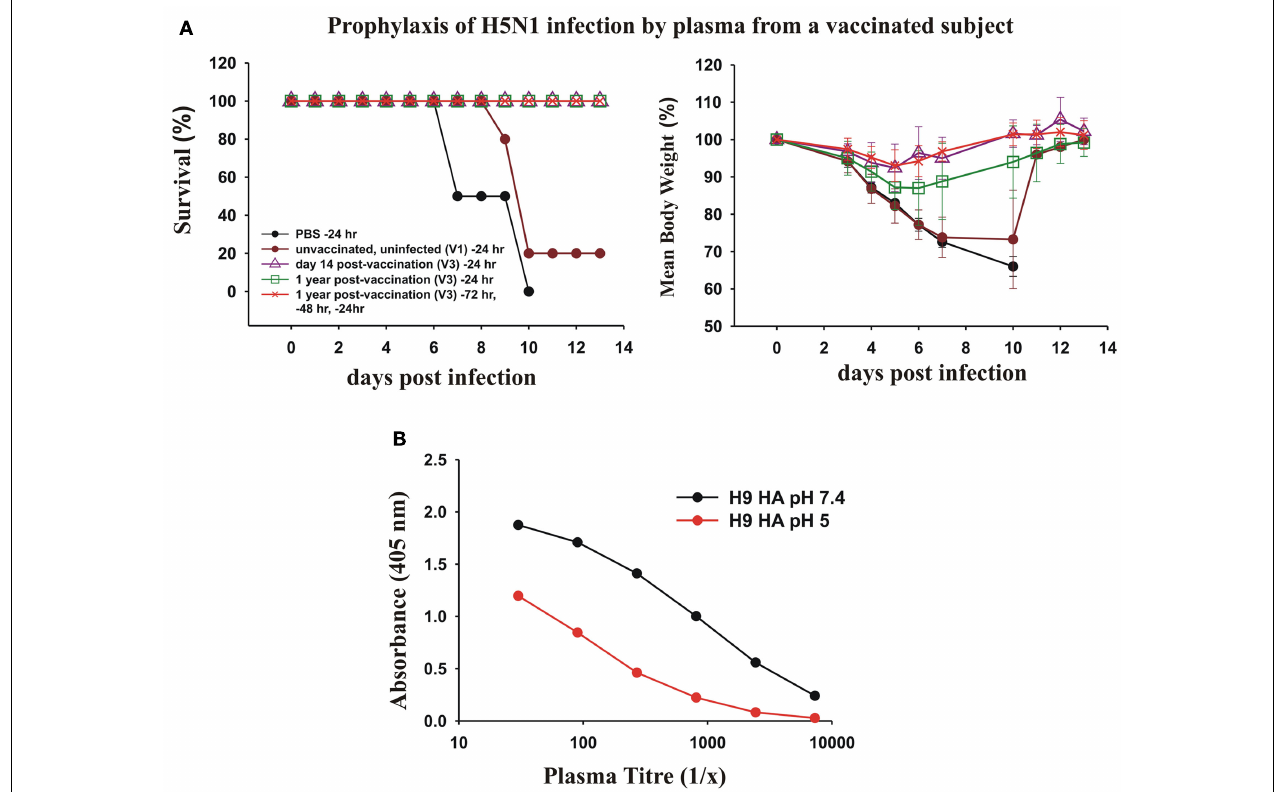
after pdmH1N1 vaccination, and as a control, plasma from a young individual unvaccinated and uninfected with pdmH1N1, collected in 2006. Another group of five mice were pre-treated 72, 48, and 24h prior to infection with 400 μ l of plasma fromV3 collected 1year after pdmH1N1 vaccination. (B) pH 5 treatment of H9 HA drastically decreases the binding ofV3 sera compared with binding of H9 HA treated at pH